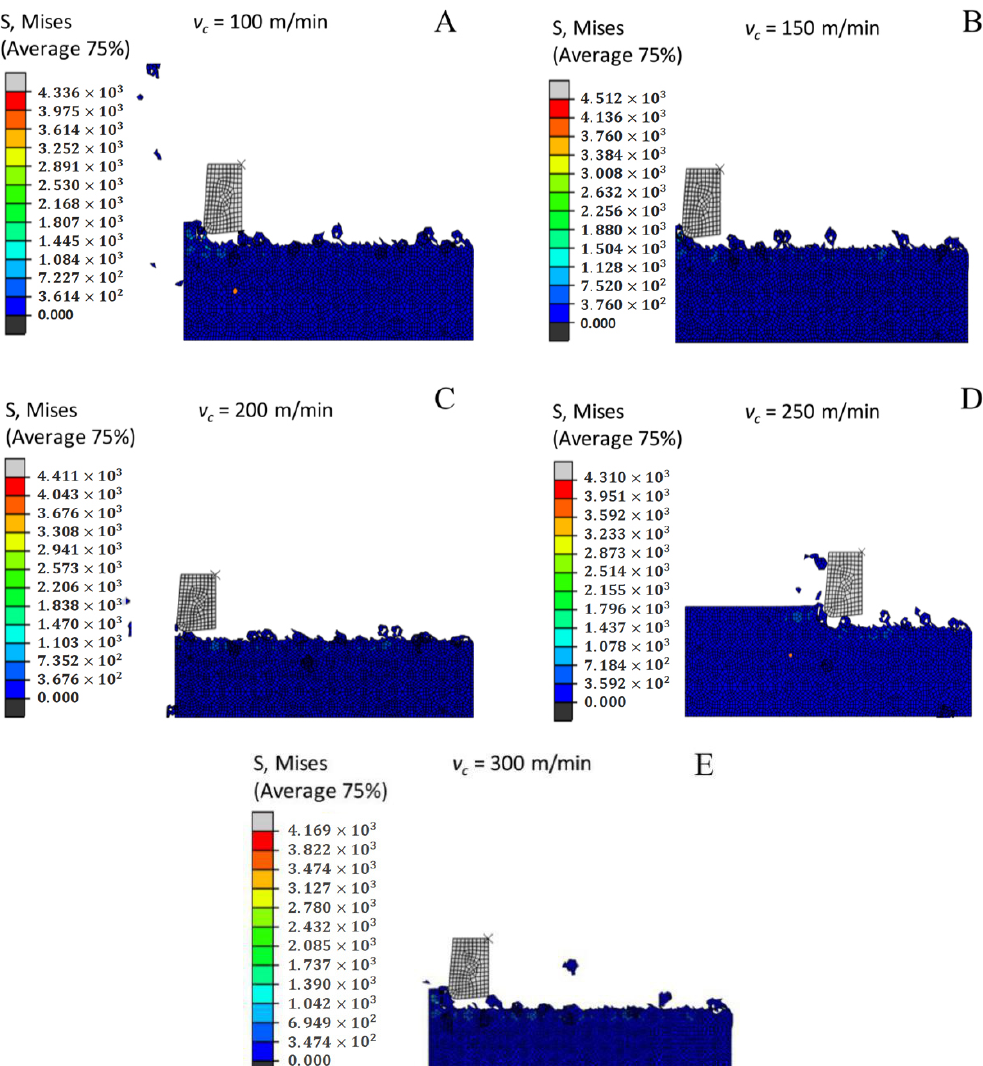
Figure 13. Cloud chart of cutting stress distribution under different milling speeds. ( A ) v c = 100 m/min. ( B ) v c = 150 m/min. ( C ) v c = 200 m/min. ( D ) v c = 250 m/min. ( E ) v c = 300 m/min.